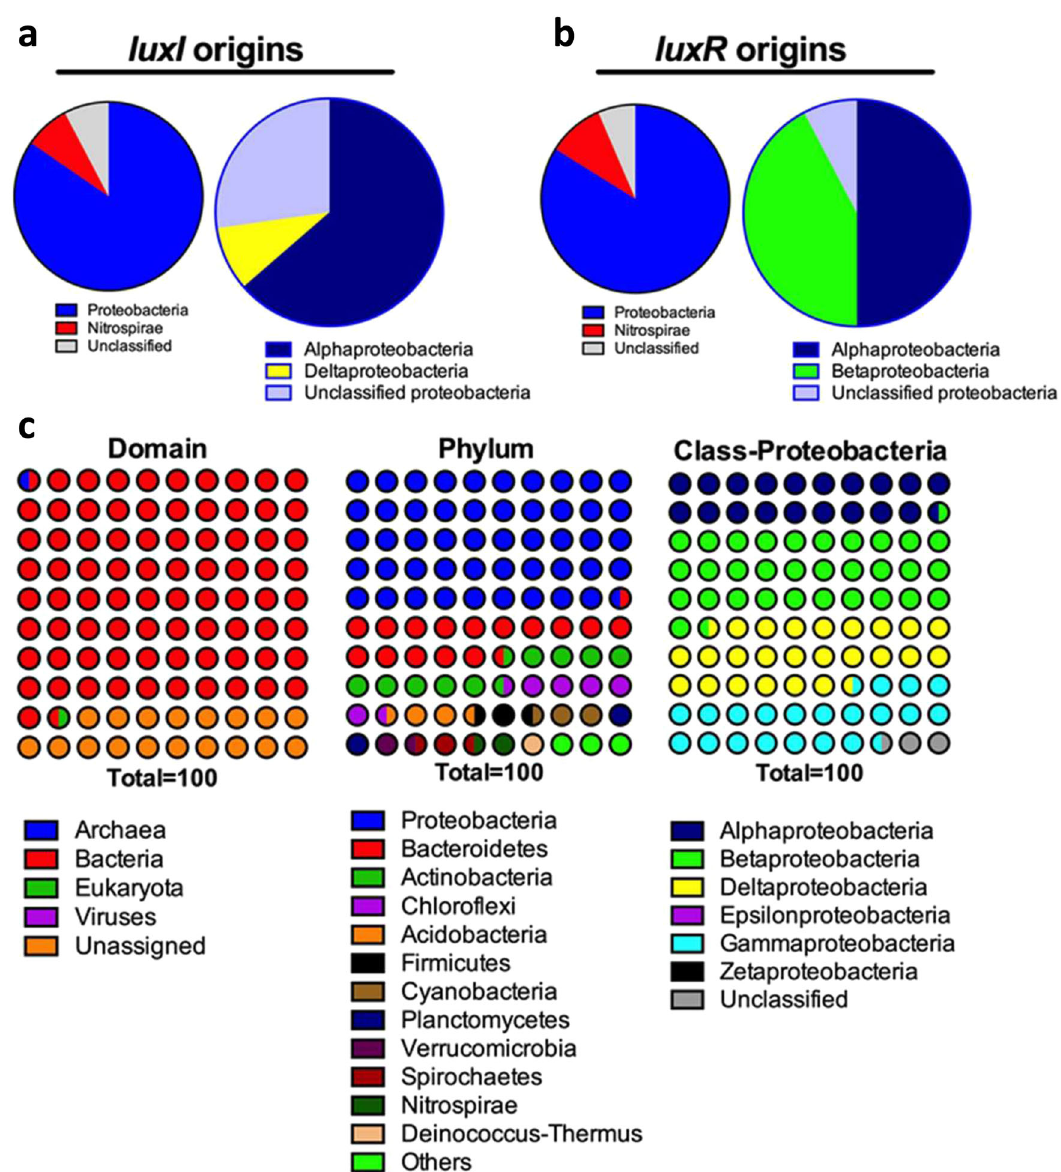
Fig. 3 Taxonomy association of AHL signal and AHL response genes in the activated sludge community. Pie charts show the taxonomic distribution of AHL signaler ( a ) and AHL responder ( b ) at the phylum level (left) and within the Proteobacterial class (right) based on the contig ORFs analysis. The taxonomic distribution of the total community at domain, phylum, and Proteobacterial classes ( c ) based on the ORFs analysis of metagenomic